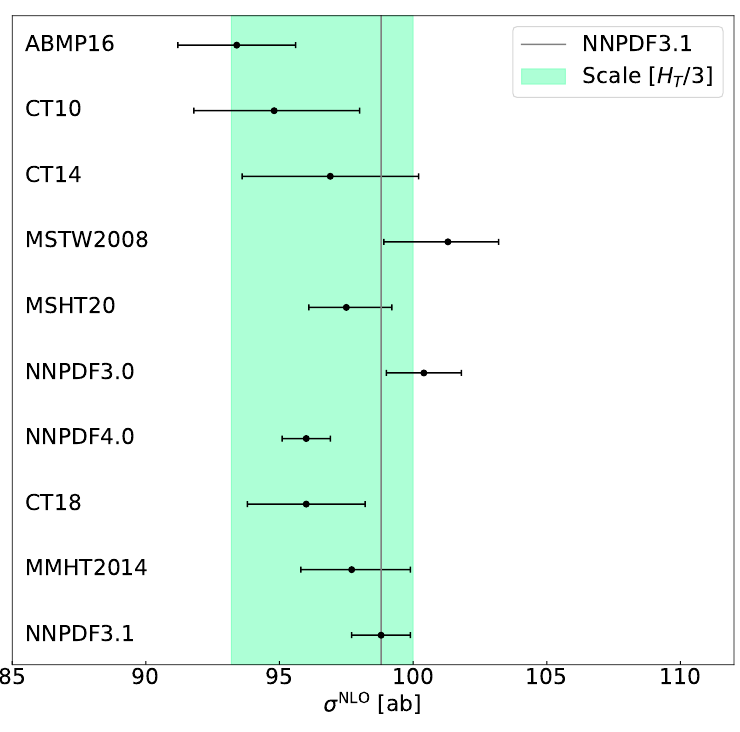
Figure 4 . NLO integrated fiducial cross sections for pp → e + ν e µ − ¯ ν µ b ¯ b τ + τ − + X at the LHC with √ s = 13 TeV. Theoretical results are provided for µ R = µ F = µ 0 = H T / 3 as well as for various PDF sets. Scale uncertainties are reported for the NNPDF3.1 PDF set and are shown as a blue